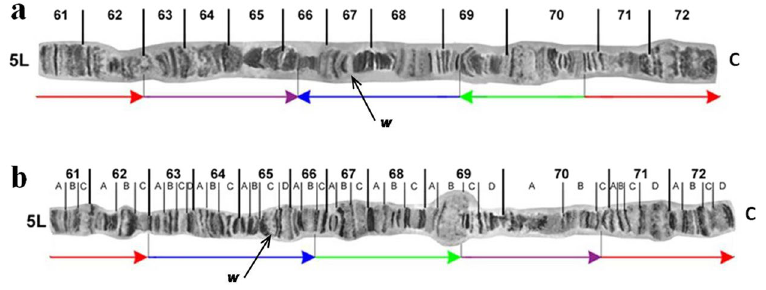
Figure 5. Comparison of the 5L polytene chromosome arms of Ceratitis fashiventris and Ceratitis capitata . ( a ) The 5L polytene chromosome arm of C . fasciventris ; ( b ) The 5L polytene chromosome arm of C . capitata . Horizontal arrows of the same color show the position and relative orientation of the putative corresponding chromosome segments between the two species. Vertical black lines underneath the chromosomes show the proposed breakpoints. Black arrows indicate the hybridization site of the w probe in each species. C indicates the centromere.